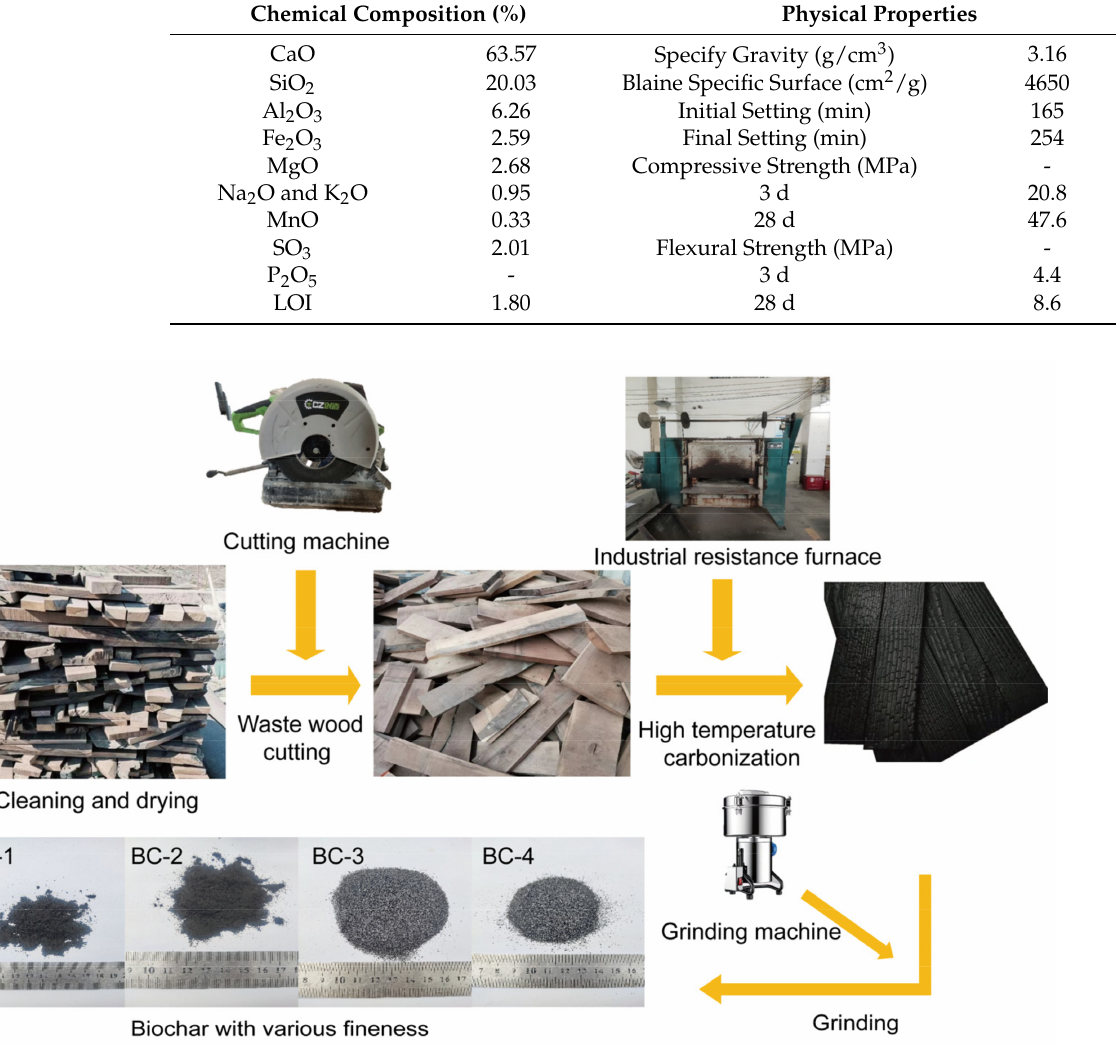
Figure 1. Flow chart of biochar